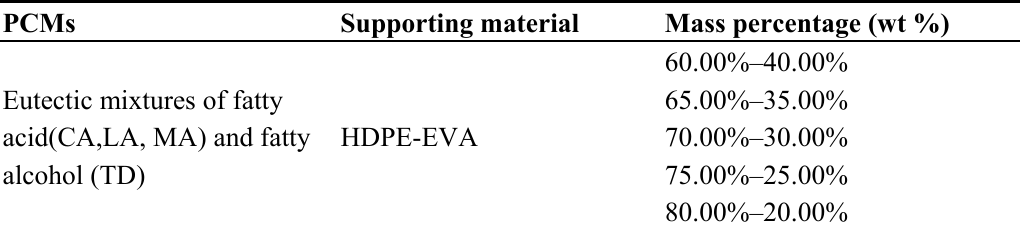
Table 3. The mass ratio of form-stable phase change materials